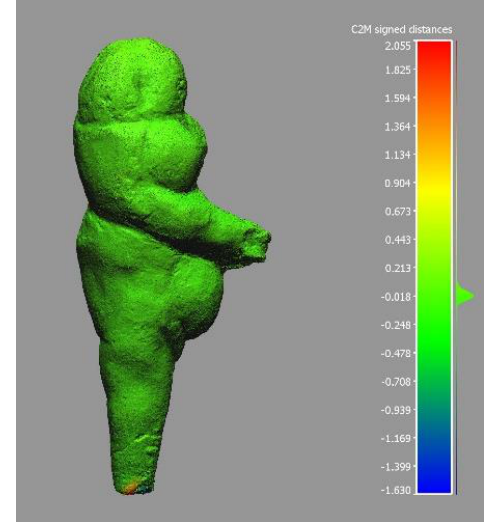
Figure 11. Colour map of the distances between point cloud from SFM and model from laser